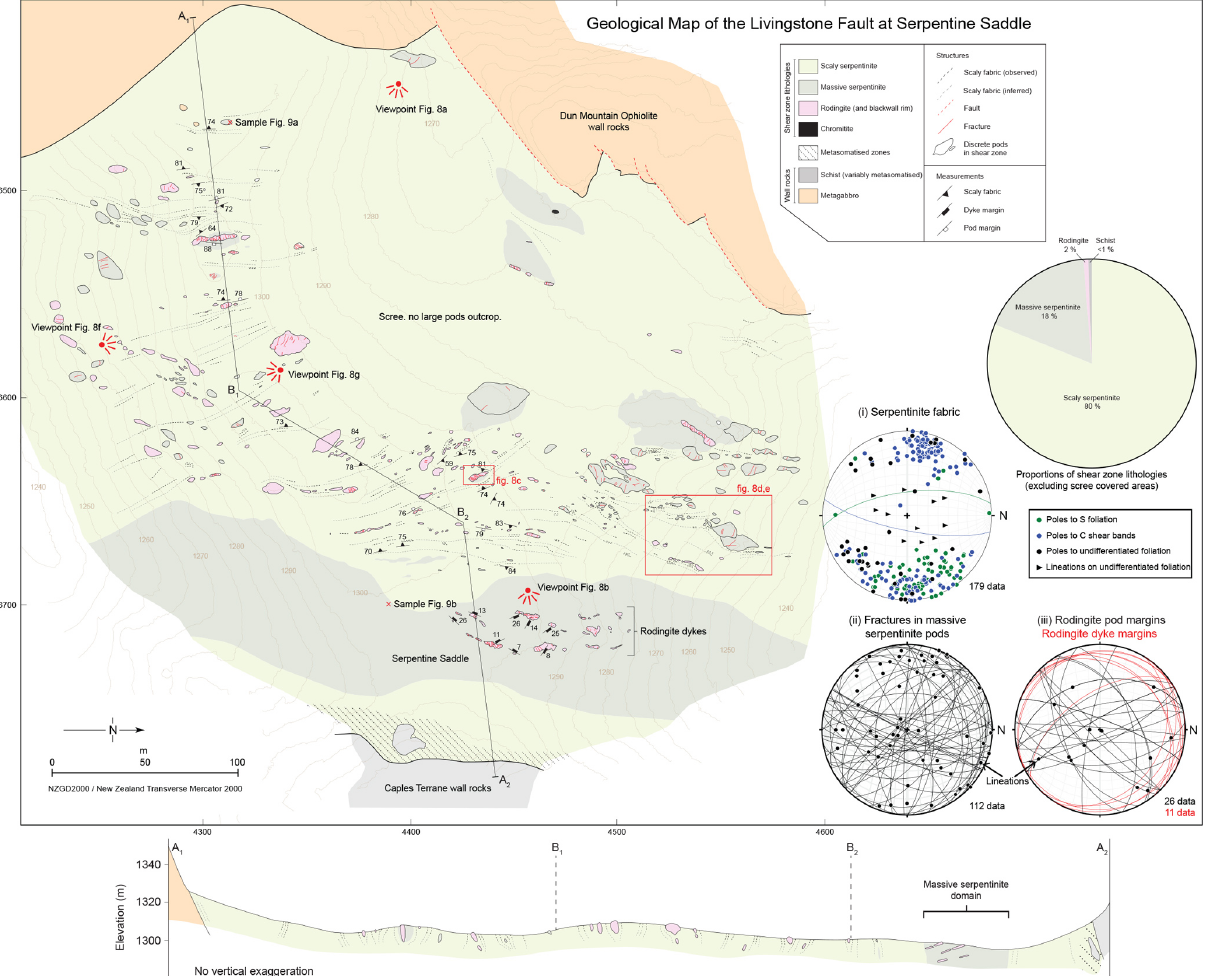
Figure 7. Detailed geological map and cross section of the Livingstone Fault at Serpentine Saddle derived from field mapping onto high- resolution, drone-acquired orthophotos. The map highlights the internal structure and composition of the serpentinite shear zone at this locality, including the traces of the scaly fabrics, pods of rodingite and massive serpentinite, and larger domains of massive serpentinite containing gently dipping rodingite dykes. The locations of images shown in Fig. 8, and some samples shown in Fig. 9, are also indicated. Stereonets (lower hemisphere, equal area) show measurements of (i) S–C fabrics, undifferentiated scaly foliation, lineations in the shear zone, (ii) brittle faults and associated lineations that cut through massive serpentinite pods, (iii) the margins of rodingite dykes and pods, and lineations on slickensided margins of pods. The pie chart shows the abundance of the most important lithologies within the shear zone in the mapped area (wall rocks are excluded). Light brown lines are topographic contours at 5m